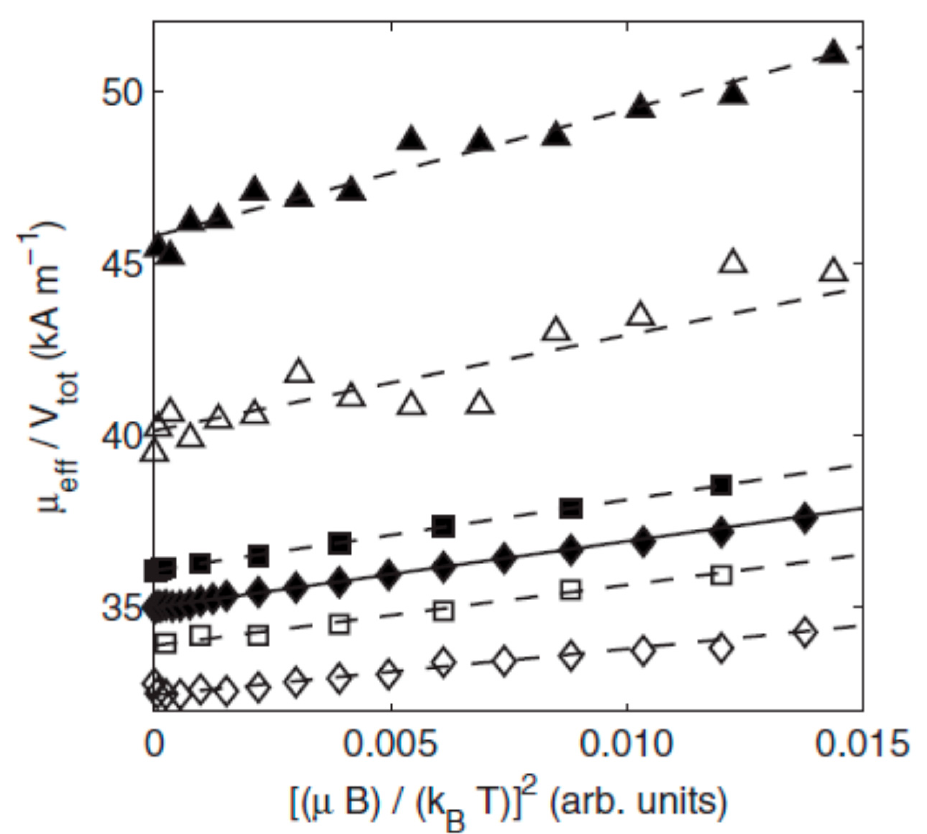
Figure 26. MMC effective magnetic moment dependence on the field induction square for several types of constituent nanoparticles: particle rotation in the liquid and interaction with the external field (filled diamonds), particle rotation in the liquid, interaction with the external field and lognormal size distribution of the MMCs (filled squares: D m = 12 nm and σ = 1 nm, filled triangles: D m = 12 nm and σ = 3 nm), particle rotation in the liquid, interaction with the external field and dipole-dipole interactions between the MMCs (open diamonds), and particle rotation in the liquid, interaction with the external field, log-normal size distribution of the MMCs and dipole-dipole interactions between the MMCs (open squares: D m = 12 nm and σ = 1 nm, open triangles: D m = 12 nm and σ = 3 nm). (Reprinted figure from [269]. Copyright 2009 by the American Physical